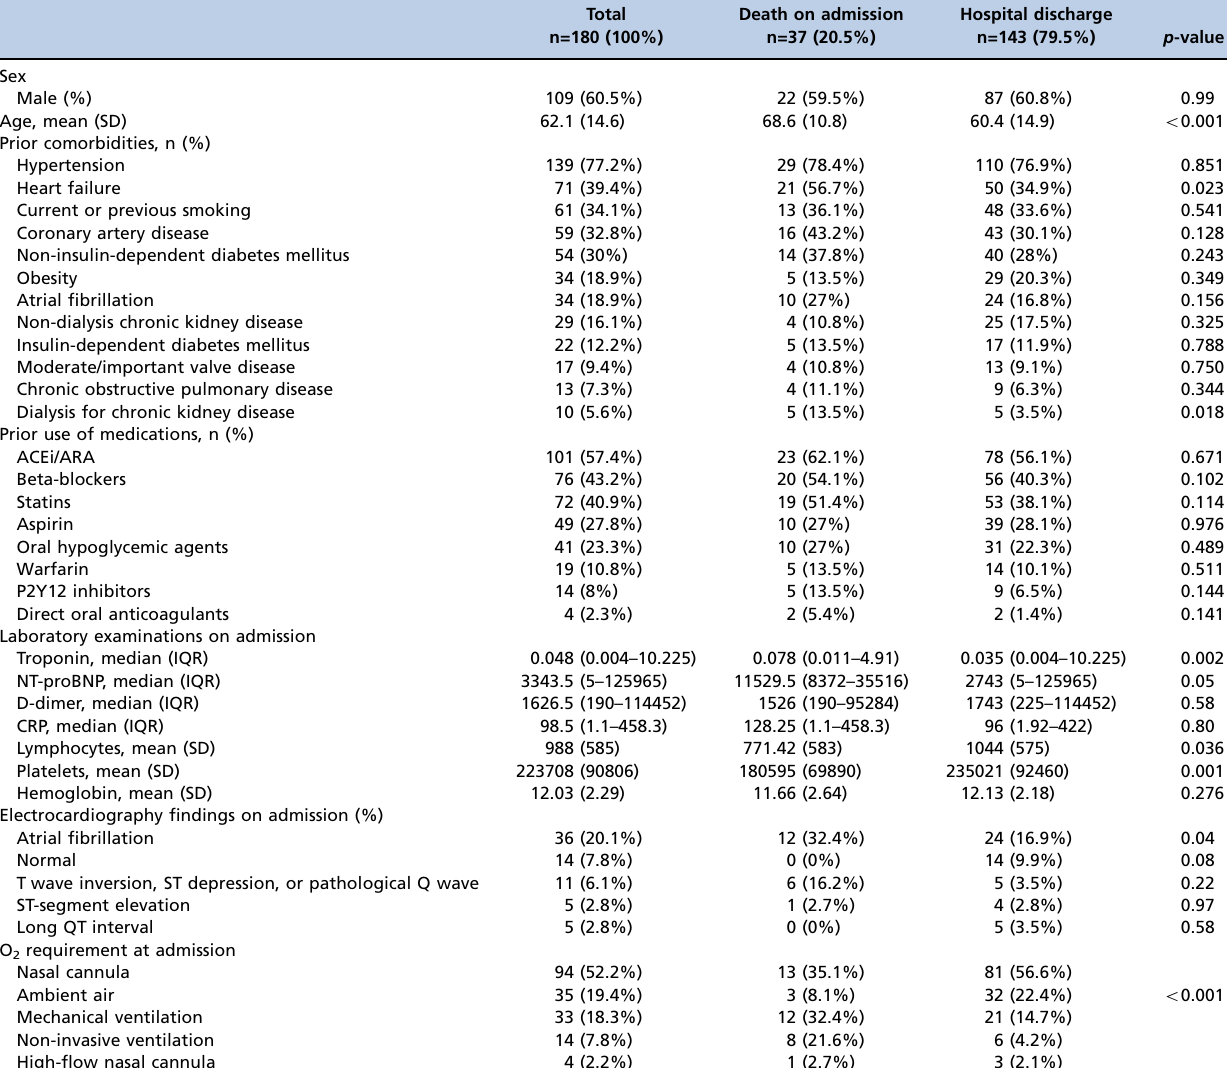
Figure 1 - Reasons for requesting a cardiology referral. Other reasons: syncope, pericardial effusion, congenital heart disease, hypertension, and endocarditis. Data labels display the absolute number of Table 1 - Clinical and demographic data and complementary examinations at admission.